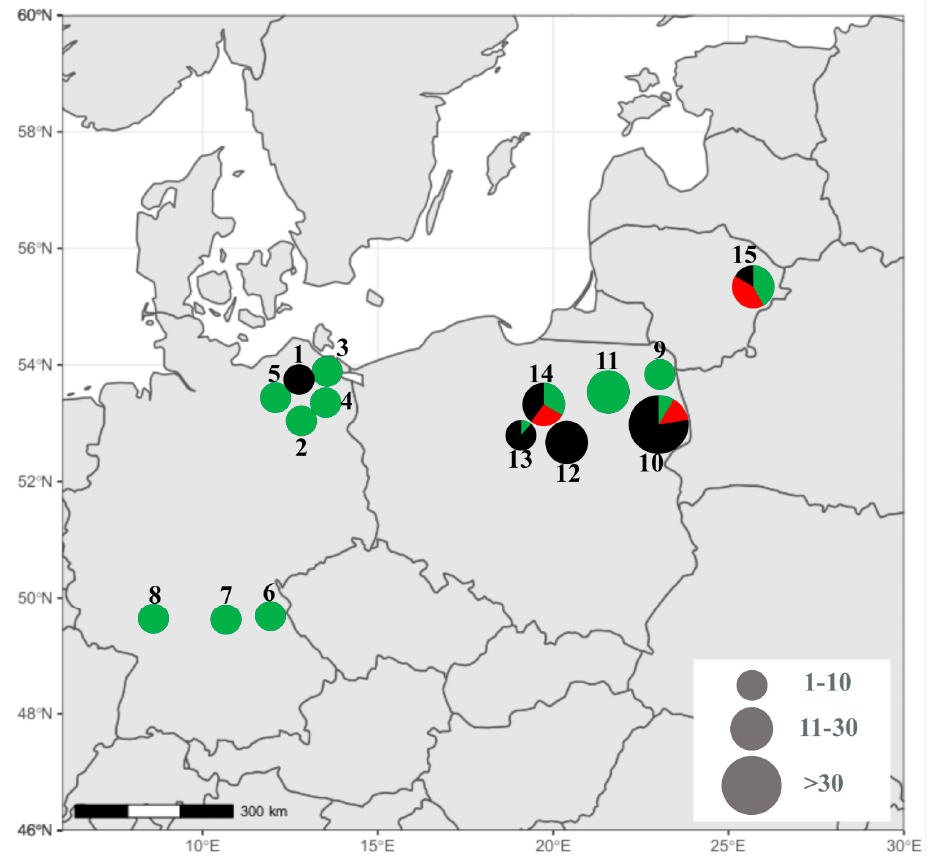
Figure 1. Geographical distribution of studied populations of V. epipsila (red color), V. palustris (green color) and their putative hybrids (black color). Pie charts present the frequency of taxa in each population. Origin of samples: 1—Warrenzin (N_NE2), 2—Mirow (N_NE3-6), 3—Trantow (N_NE7-